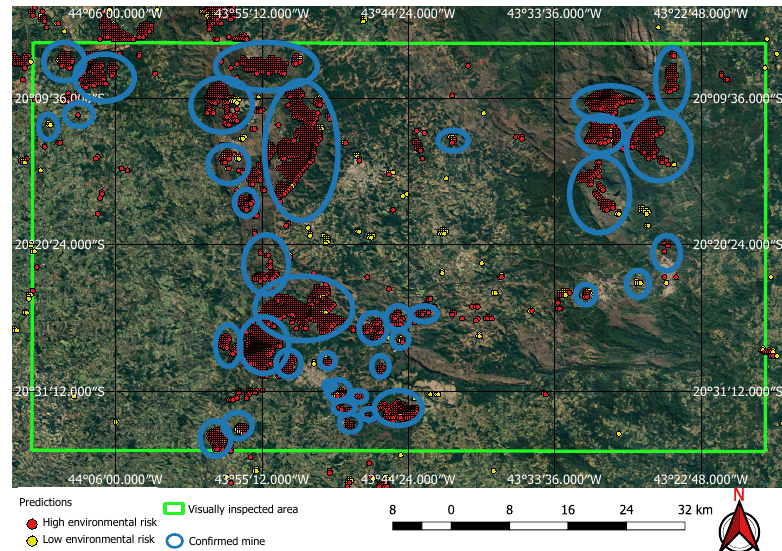
Figure 11. Visual inspection of neural network